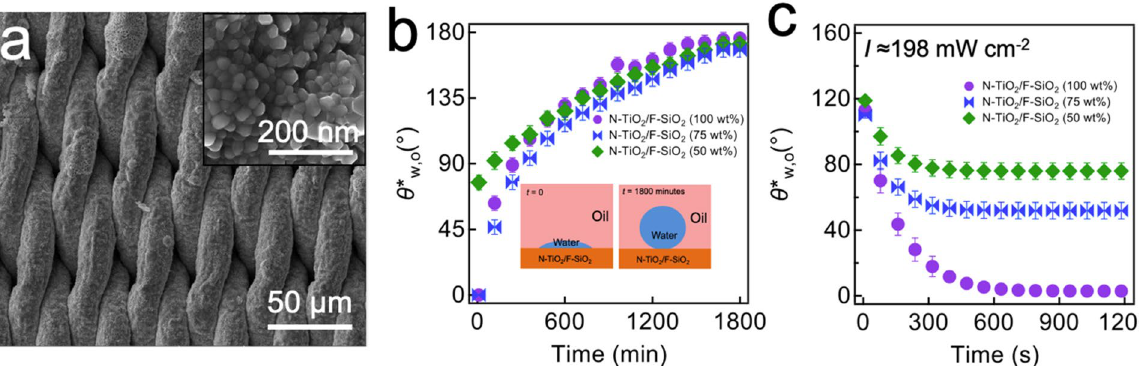
Figure 1. N-TiO 2 /F-SiO 2 coated mesh surface morphology and evolution of water wettability under oil. (a) Scanning electron microscopy (SEM) image of stainless steel (SS) 316 Twill Dutch weave mesh coated with N-TiO 2 /F-SiO 2 (50 wt%). The inset shows a higher magnification SEM image of the mesh surface. (b) The measured apparent contact angles for water on the mesh surfaces coated with N-TiO 2 /F-SiO 2 mixture with various N-TiO 2 concentrations (50 wt%, 75 wt%, and 100 wt%) that are submerged in an oil (n-hexadecane) bath as a function of submerging time. The inset images illustrate schematics of the time-dependent evolution of the water contact angles on a mesh surface submerged in oil. (c) The measured apparent contact angles for water on the mesh surfaces coated with N-TiO 2 /F-SiO 2 mixture with various N-TiO 2 concentrations (50 wt%, 75 wt%, and 100 wt%) while being illuminated by visible light (Intensity ( I ) = 198 mW cm −2 ). Note that all meshes were precontaminated by oil for 600